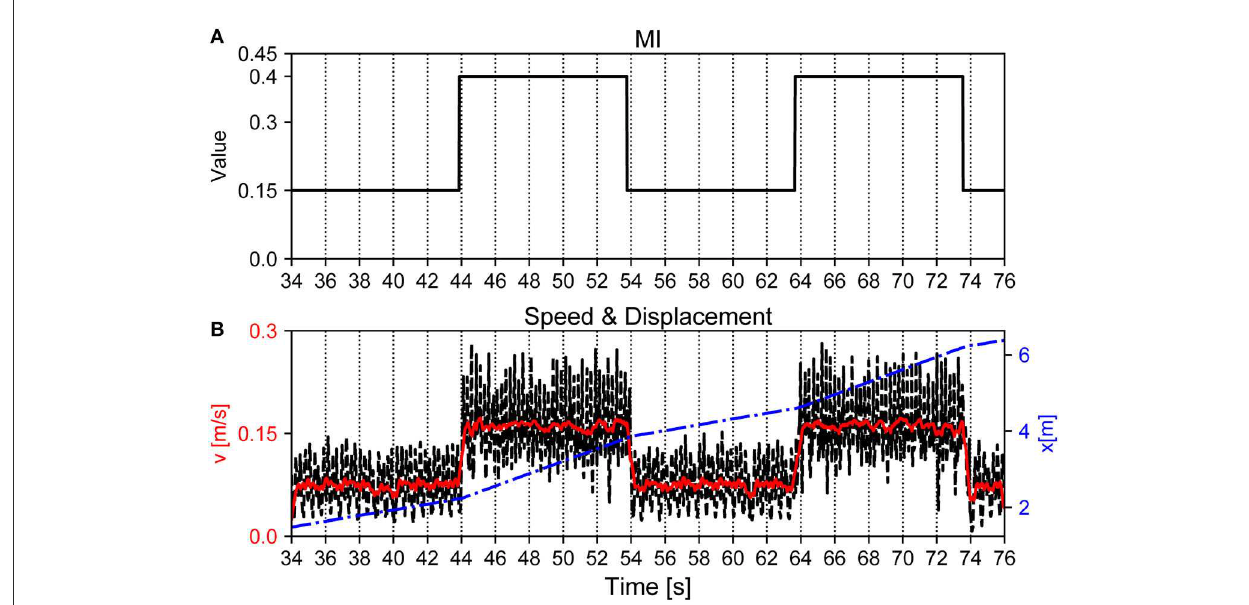
FIGURE13 Walking speed of Lilibot adjusted by tuning MI of the CPGs. (A) Changes of MI of the CPGs. (B) Walking speed of the robot during the corresponding time. The black and red lines are the instantaneous and average speeds of the trunk with reference to the inertial frame, respectively. The blue line indicates the displacement of the